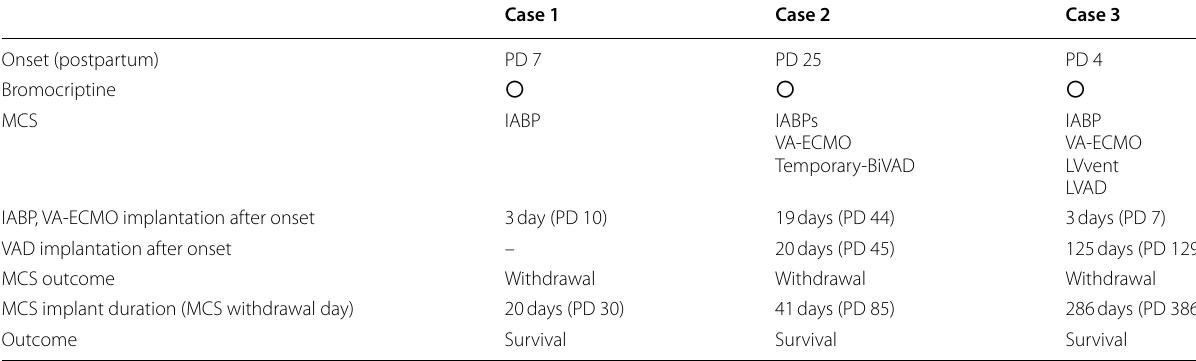
Table 2 Treatment details of 3 cases